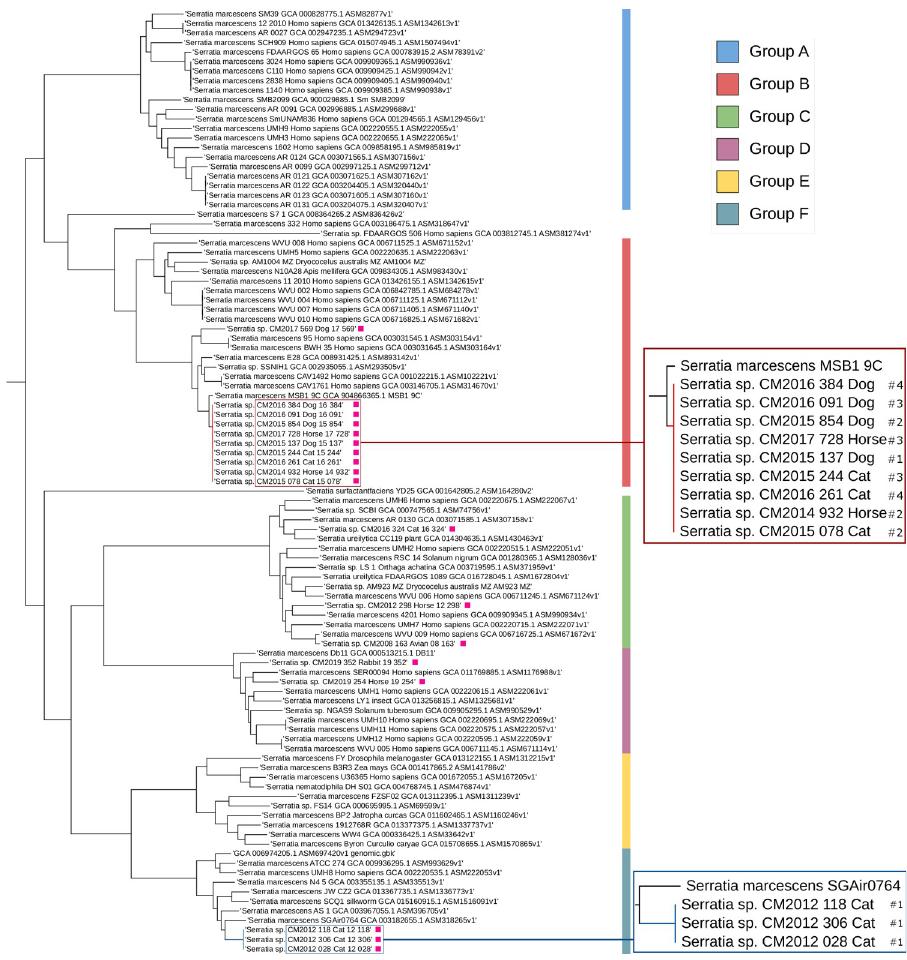
Fig 2. Core-genome phylogeny inferred from SNP analysis of the S . marcescens “ sensu-lato” group, suggesting a quasi-clonal relation amongst the MDR isolates. An unrooted tree was generated from the multiple alignment containing high-quality SNP, Indels, and structural variations within the core genome, by Parsnp, from 81 complete genomes using strain ATCC_13880 as a reference and excluding potential recombination sites. The resulting tree was retrieved from the Parsnp output files and decorated with iTOL. The species, strain names, host and accession numbers extracted from GenBank are specified for each node. The 18 animal isolates from the U-Vet are indicated by a pink square.